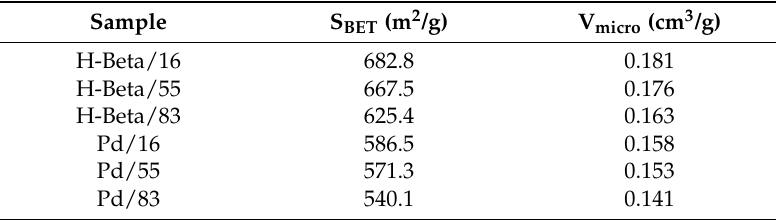
Table 3. Textural properties of H-Beta and Pd/Beta samples.